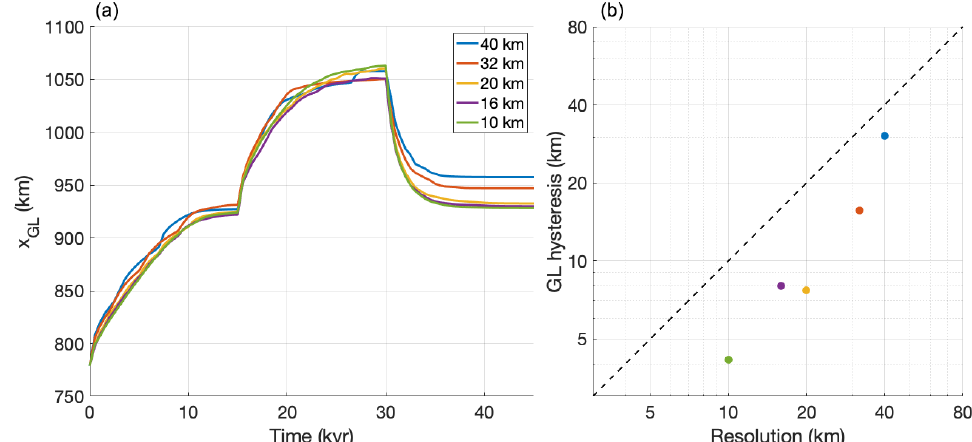
Figure 7. (a) Grounding-line position over time in the MISMIP experiment at different resolutions. The first 25kyr show the initialization phase. (b) Grounding-line hysteresis (defined as the difference in grounding-line positions between t = 15kyr and t = 45kyr) versus model